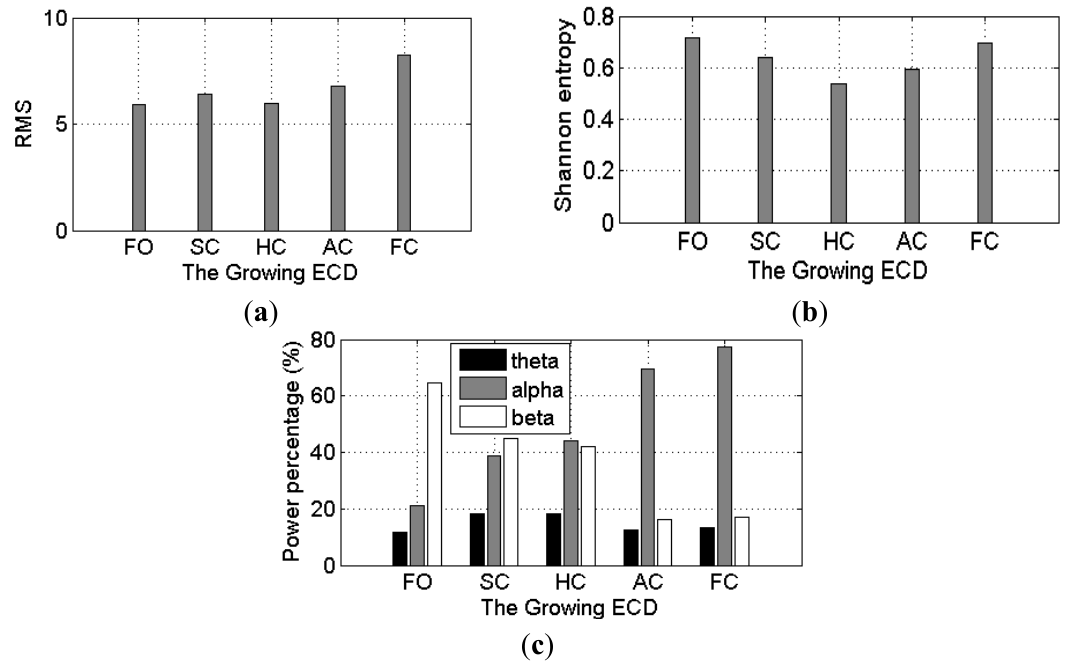
Figure 12. The time- ( a , b ) and frequency-domain ( c ) EEG features with a growth of the ECD.